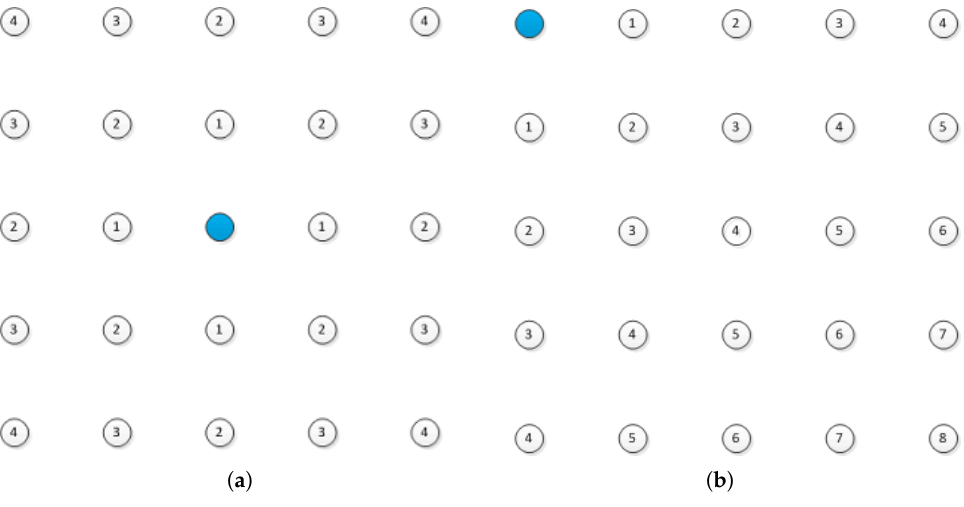
Figure 2. Network topology and placement of the Sink node. ( a ) Sink in the middle of the grid. ( b ) Sink on top left corner of the